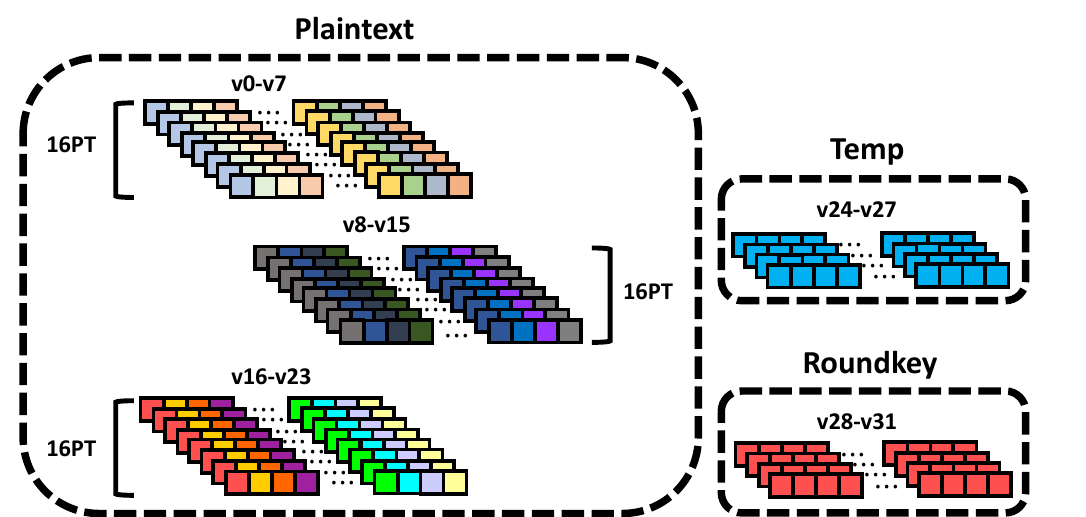
Figure 9. Proposed vector register scheduling for HIGHT. Algorithm 3 is a round function to which a data parallelism technique is applied in HIGHT. In the HIGHT optimization of [10], both task and data parallelism technique are applied, but Algorithm 3 applies only a data parallelism technique. Our contribution of Algorithm 3 is a data parallelism technique for HIGHT. As data parallelism technique